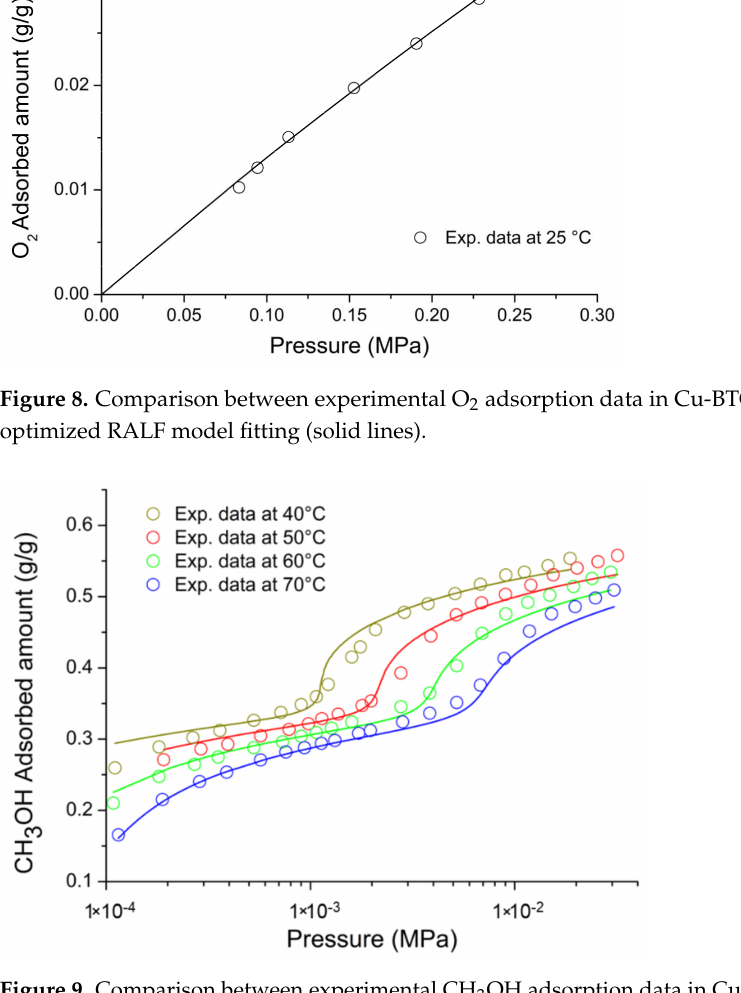
Figure 9. Comparison between experimental CH 3 OH adsorption data in Cu-BTC [58] and simultane- ous optimized (RALF/RALFHB)-DS model fitting (solid